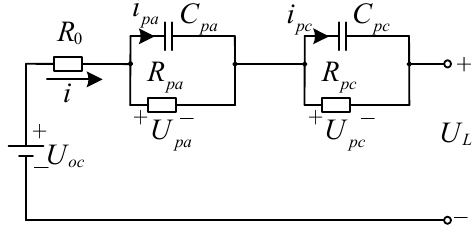
Figure 2. DP equivalent circuit